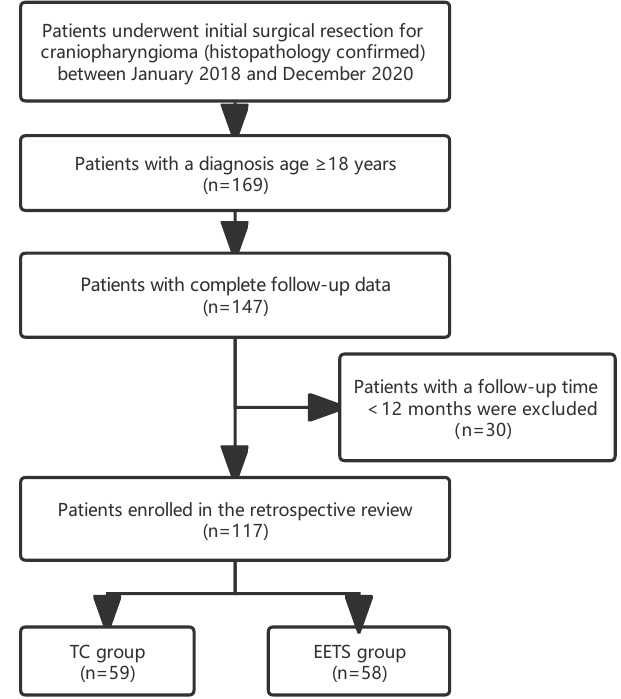
Figure 1. The flowchart of patient selection.